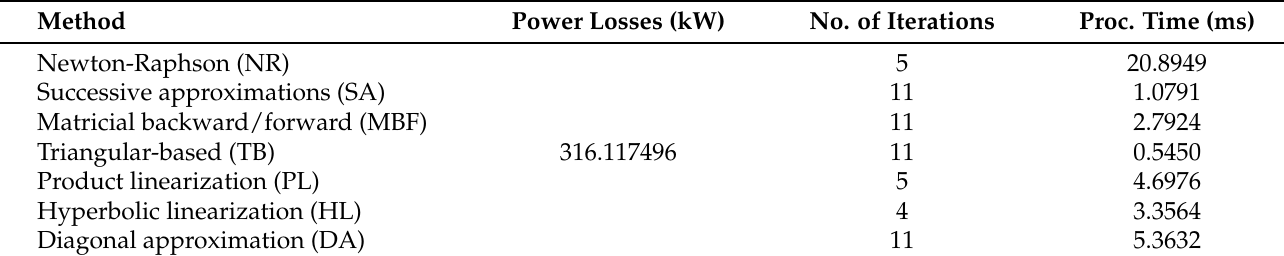
Table 5. Power flow performance in the IEEE 85-bus